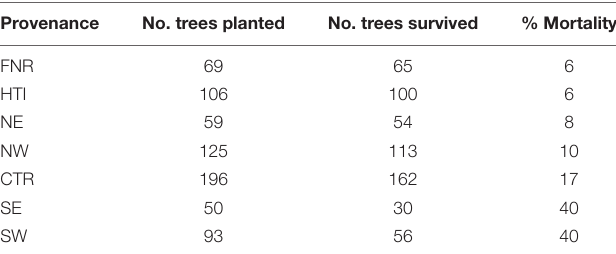
TABLE 2 | Survival by provenance, including the number of trees planted, the number of trees that survived the duration of the experiment, and the percent mortality.